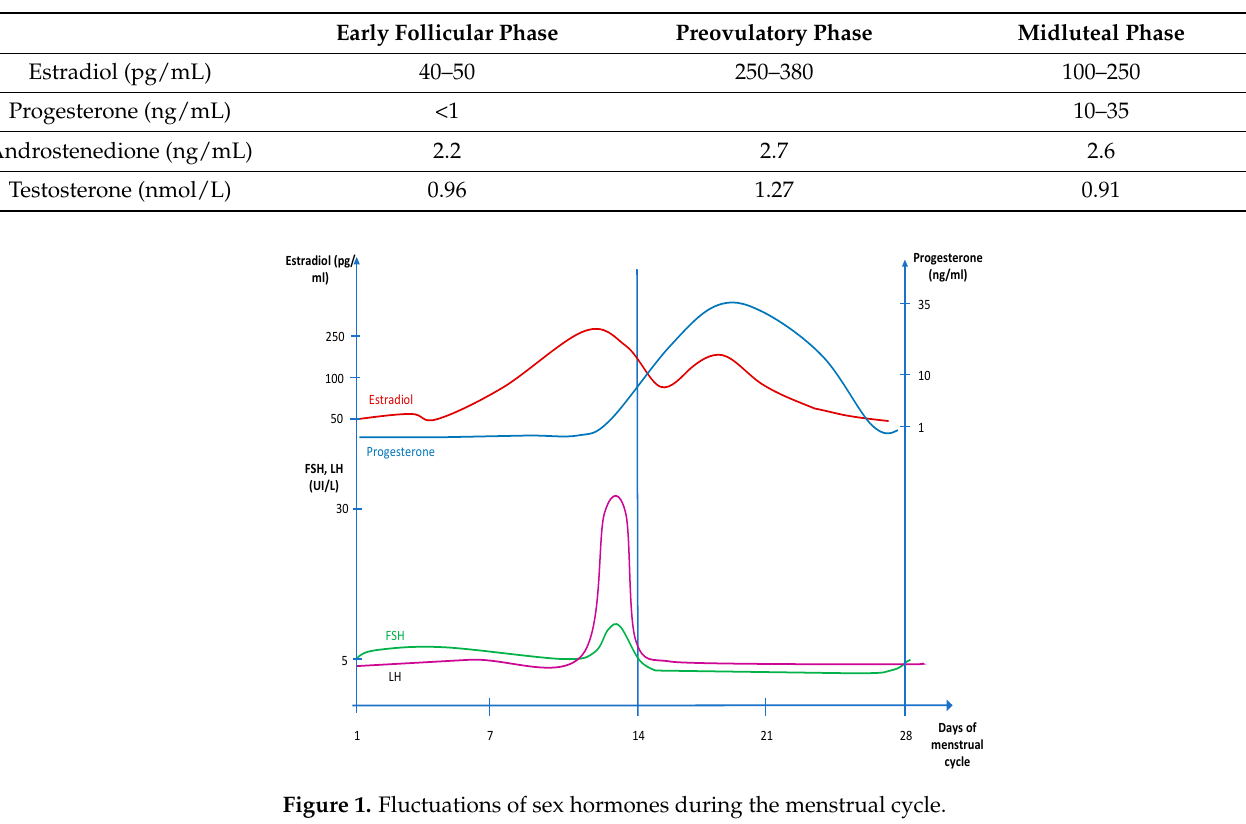
Figure 1. Fluctuations of sex hormones during the menstrual cycle.